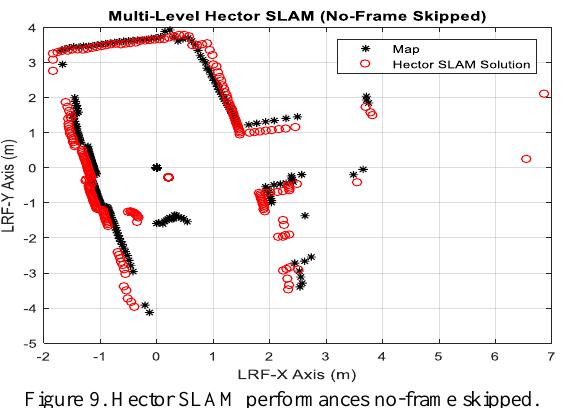
Figure 9. Hector SLAM performances no-frame skipped.